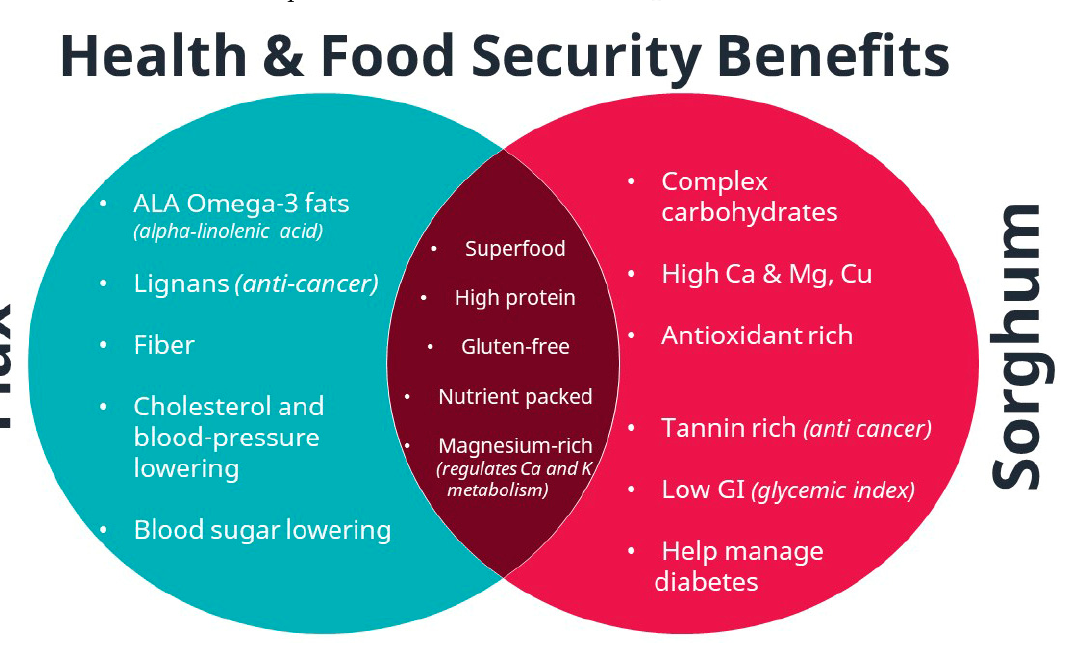
Figure 1. Potential health and food security benefits of flax and sorghum seeds.